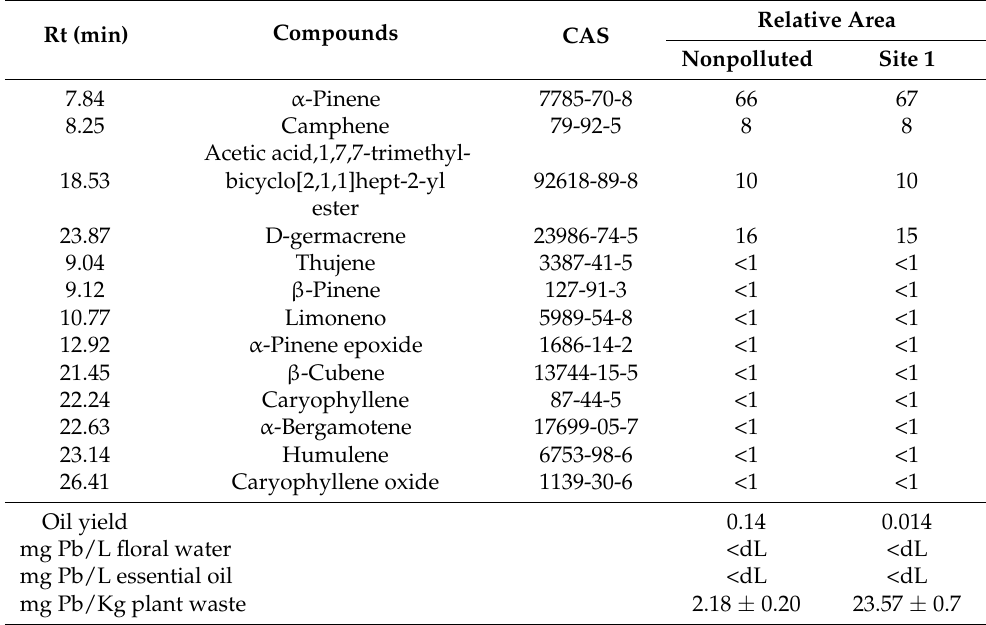
Table 3. Identification of compounds present in H. petiolaris essential oils obtained from the Pb- polluted site 1 and the nonpolluted control